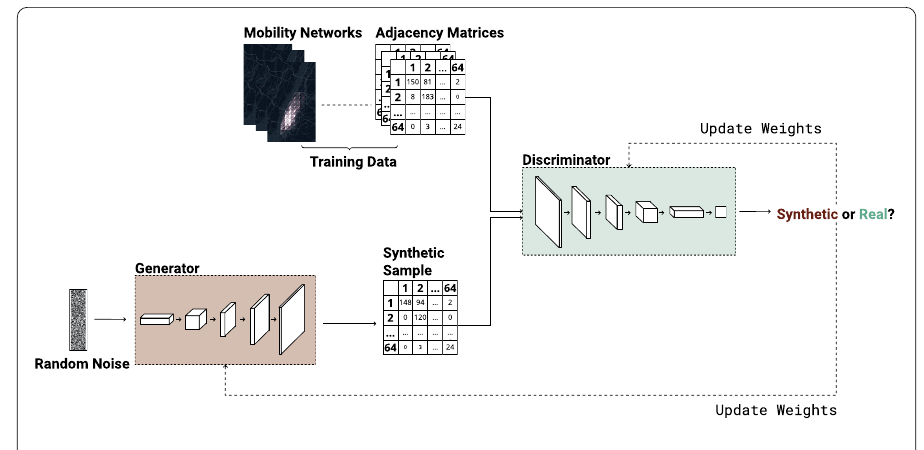
Figure 1 Architecture of MoGAN. The generator (a Convolutional Neural Network or CNN) performs transposed convolution operations that upsample the input random noise vector, transforming it into a 64 × 64 adjacency matrix representing a mobility network. The discriminator (a CNN) takes as input both the generated mobility networks and the real ones from the training set and performs a series of convolutional operations that end up with a probability, for each sample, to be fake or real. Both the discriminator’s and generator’s weights are then